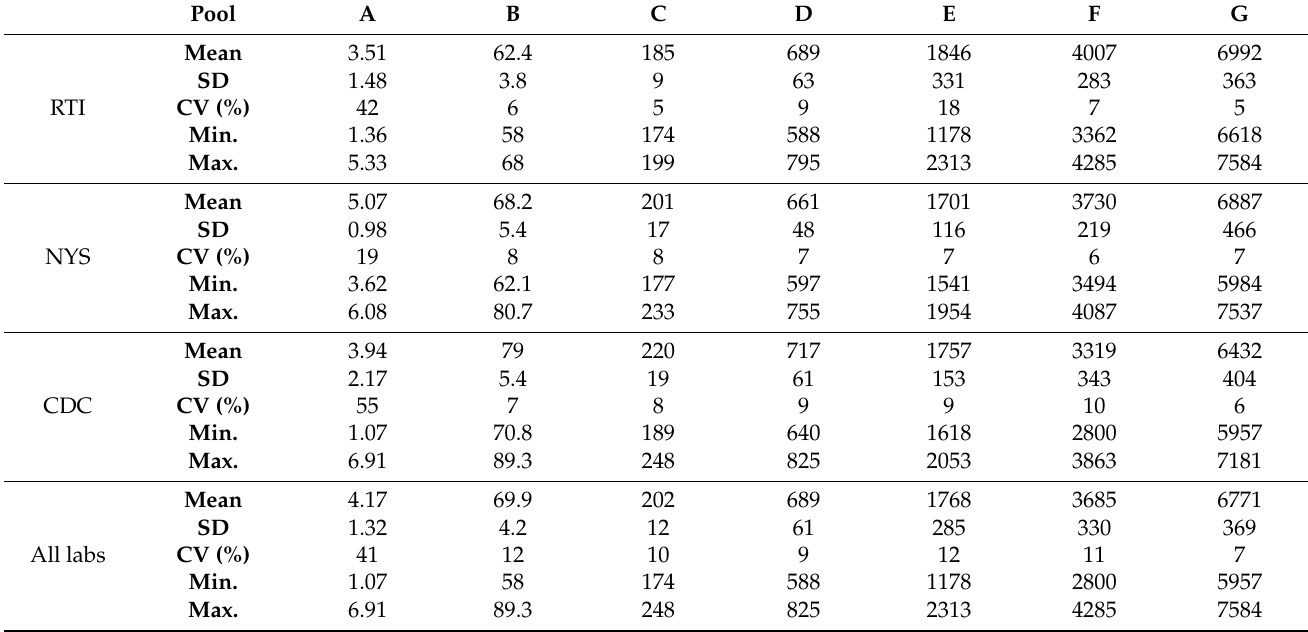
Table 2. Descriptive statistics from CK-MM measurements (ng/mL) over three weekly runs with results from each run in triplicate from all three